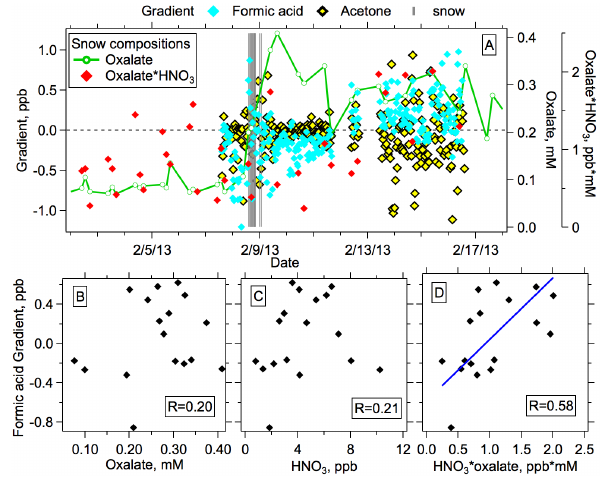
Figure 8. (a) Time series of concentration gradients of formic acid and acetone during UBWOS 2013. Time series of oxalate measured in melted snow water and the product of oxalate in the snow and ni- tric acid (HNO 3 ) in ambient air are also shown. The vertical black bars indicate periods with snowfall. (b) Scatter plot of concentra- tion gradient of formic acid vs. oxalate in the snow. (c) Scatter plot of concentration gradient of formic acid vs. nitric acid concentra- tion in ambient air. (d) Scatter plot of concentration gradients of formic acid vs. the products of oxalate in the snow and nitric acid in ambient air. The blue line is the linear regression to the data